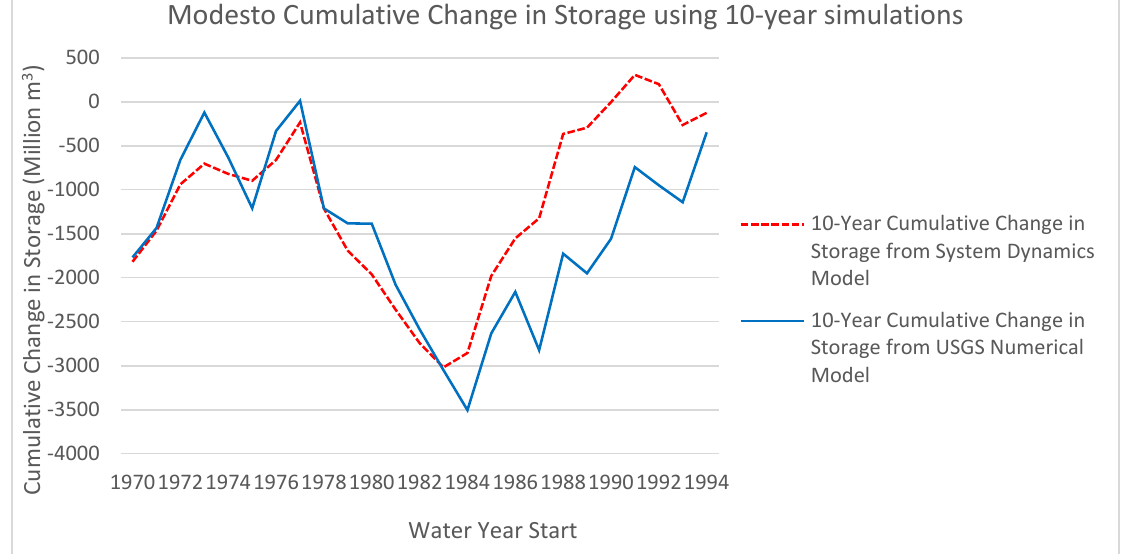
Figure 9. Modesto Basin 10-year groundwater system simulation.